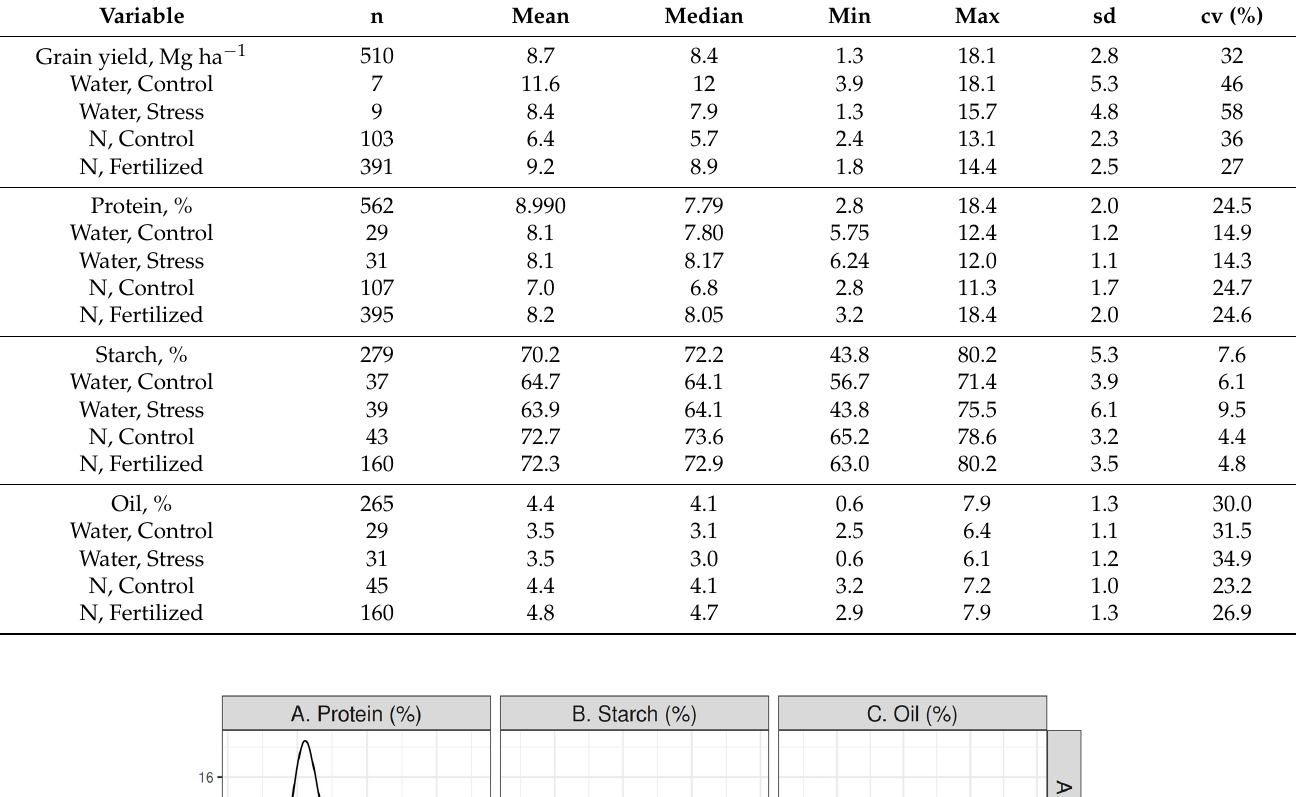
Table 2. Descriptive statistics of the reported data on maize grain yield (dry basis), protein, starch, and oil concentration split by the treatments of interest (water and nitrogen fertilizer). Main statistics are sample size (n), mean, median, minimum (min), maximum (max), standard deviation (sd), and coefficient of variation (%).